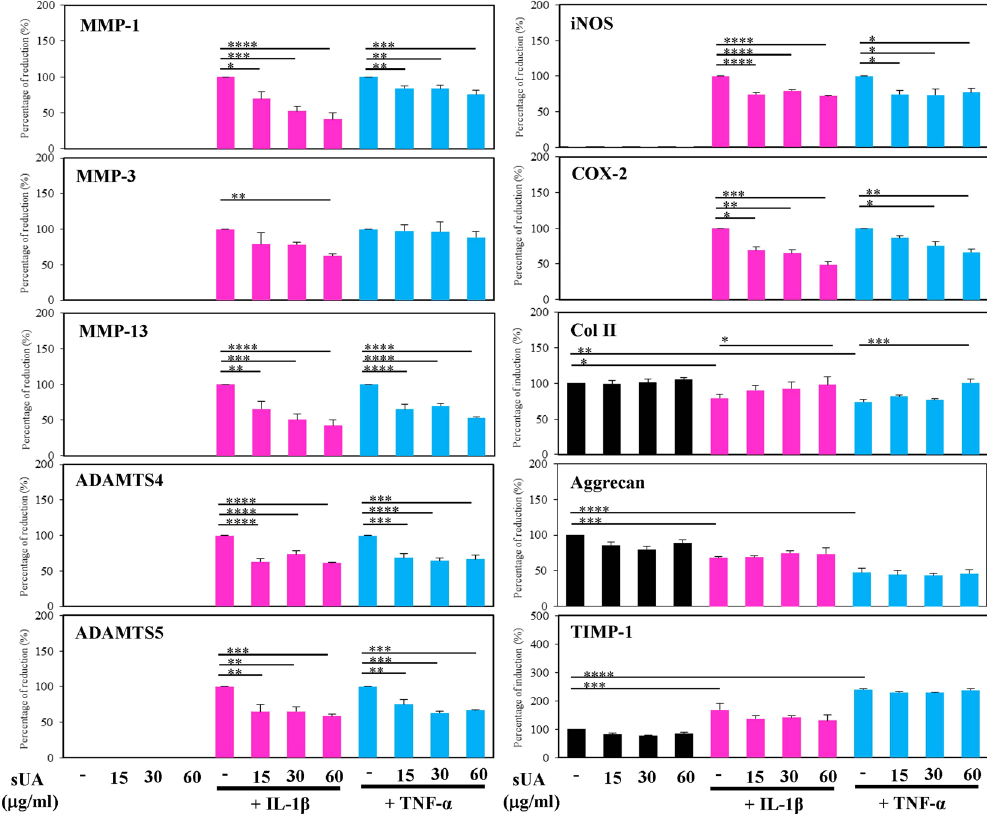
Figure 2. sUA suppressed TNF- α - and IL-1 β -induced MMP and ADAMTS mRNA expression. Porcine chondrocytes (3 × 10 6 ) in serum-free medium were treated with various concentrations of sUA for 72 h and then stimulated with 10 ng/ml IL-1 β or 1 ng/ml TNF- α for an additional 24 h. MMP-1, MMP-3,